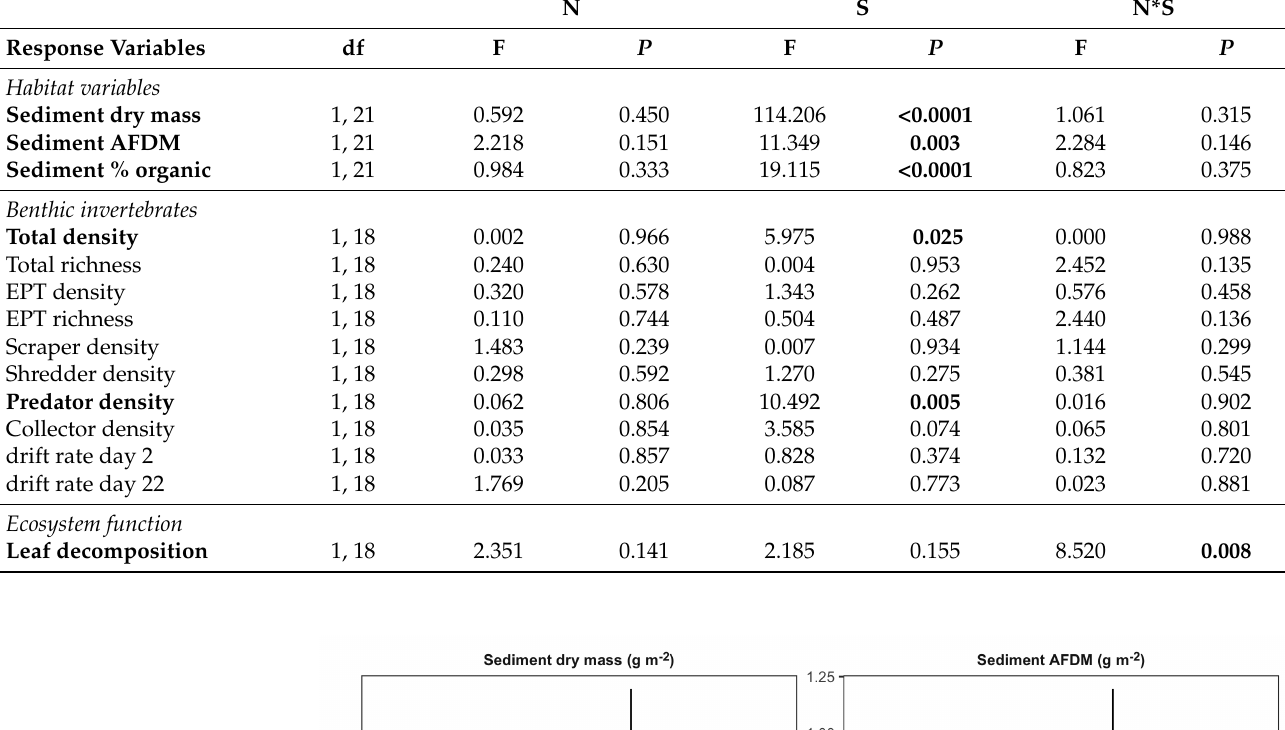
Table 1. ANOVA summary of linear models evaluating impacts of the stressor treatments on response variables of the first-order channels. Significant effects ( P < 0.05) are indicated in bold.